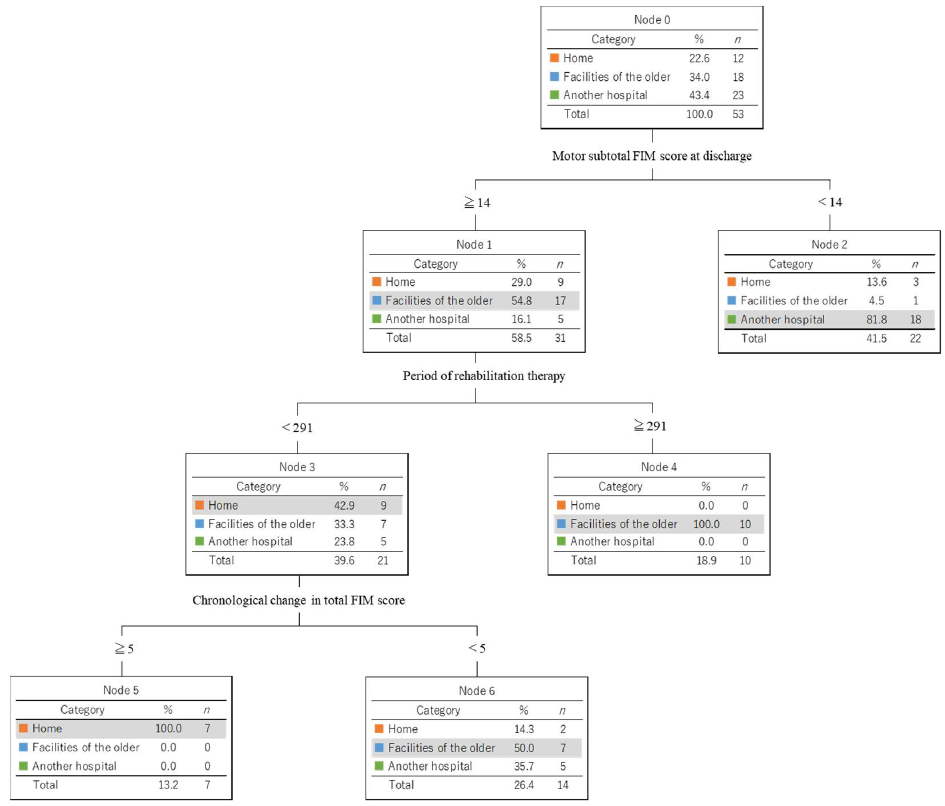
Figure 1. Results of decision tree analysis. FIM motor subtotal score, period of rehabilitation therapy, and chronological change of total FIM score were identified as discriminators at discharge or transfer after rehabilitation therapy.